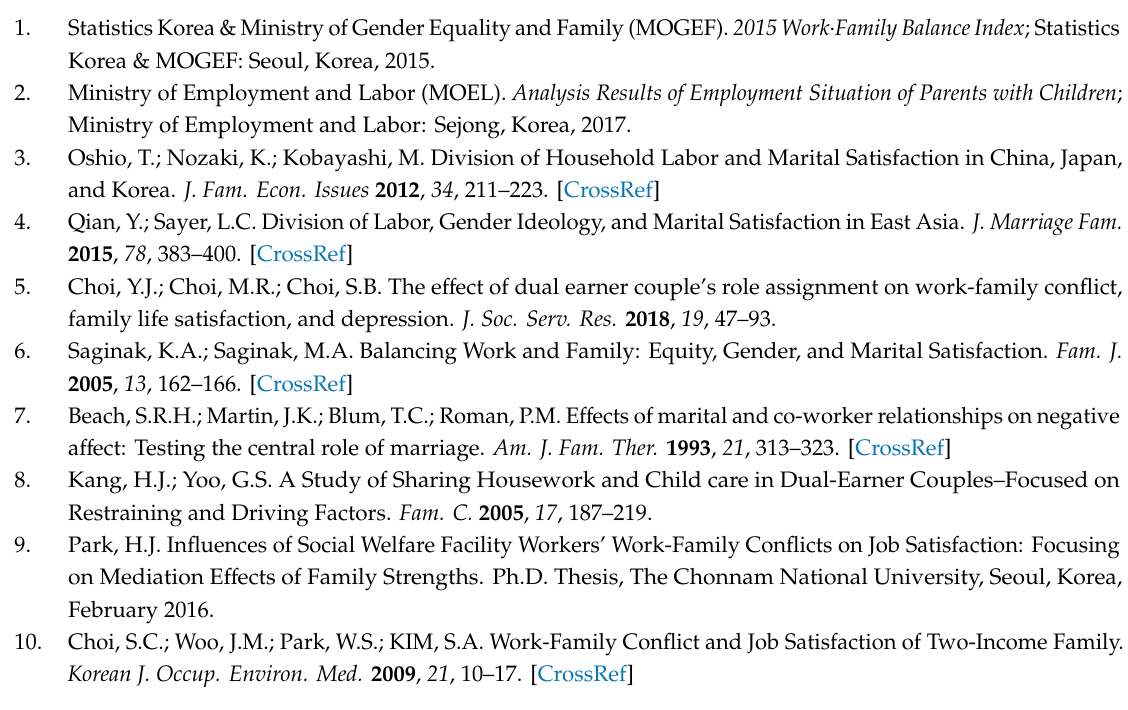
Figure S1: Selection of the study subjects; Table S1: Fit index of measured model and modified model; Table S2: Result of discriminant validity; Table S3: Comparison of fit index between hypothetical model and modified model; Table S4: Detailed questionnaires according to measured